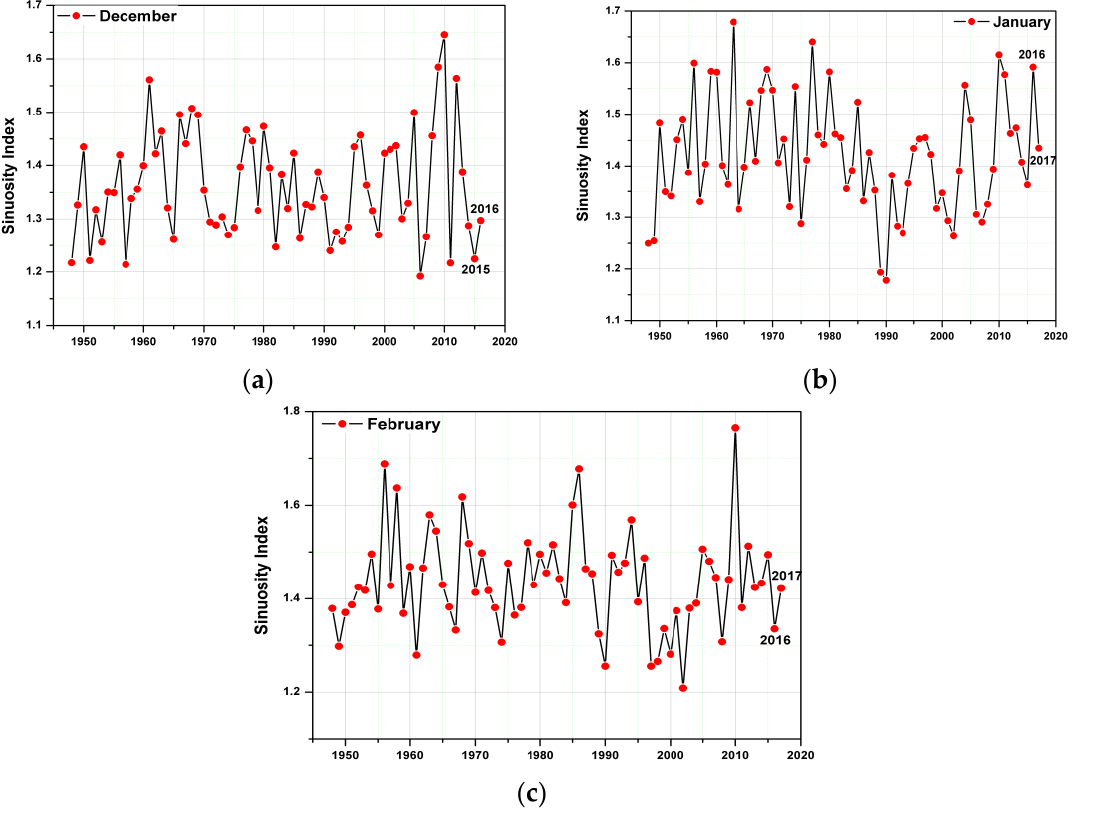
Figure 12. The sinuosity index (SIN) computed over the Northern Hemisphere for ( a ) December; ( b ) January; and ( c ) February.